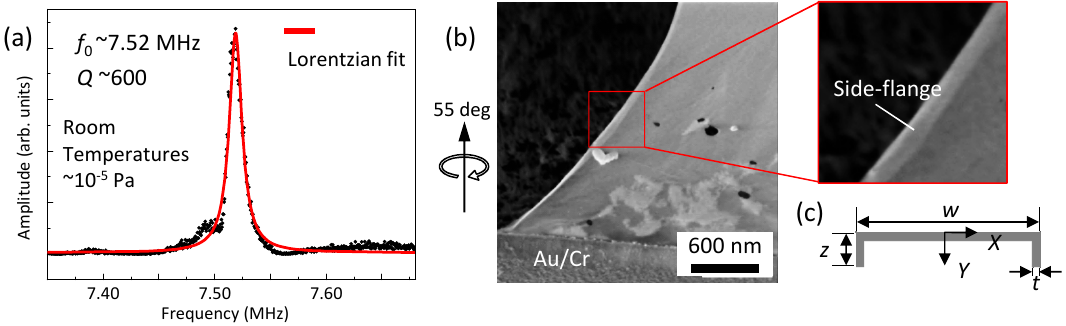
Figure 4. (Color online) ( a ) Amplitude versus frequency for the doubly-clamped trilayer graphene resonator measured at room temperatures under a vacuum of ∼ 10 − 5 Pa. ( b ) A close-up SEM image of the resonator with side-flanges (tilted at 55 ◦ ) and ( c ) a schematic side-view image of the side-flanges. Adapted from [11]. Copyright (2013) The Japan Society of Applied